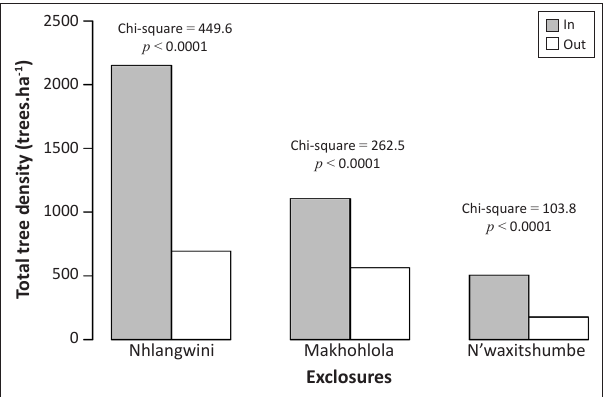
FIGURE 2: Total tree densities for all woody plants greater than 0.5 m in height inside and outside the three long-term herbivore exclosures in the Kruger National Park.